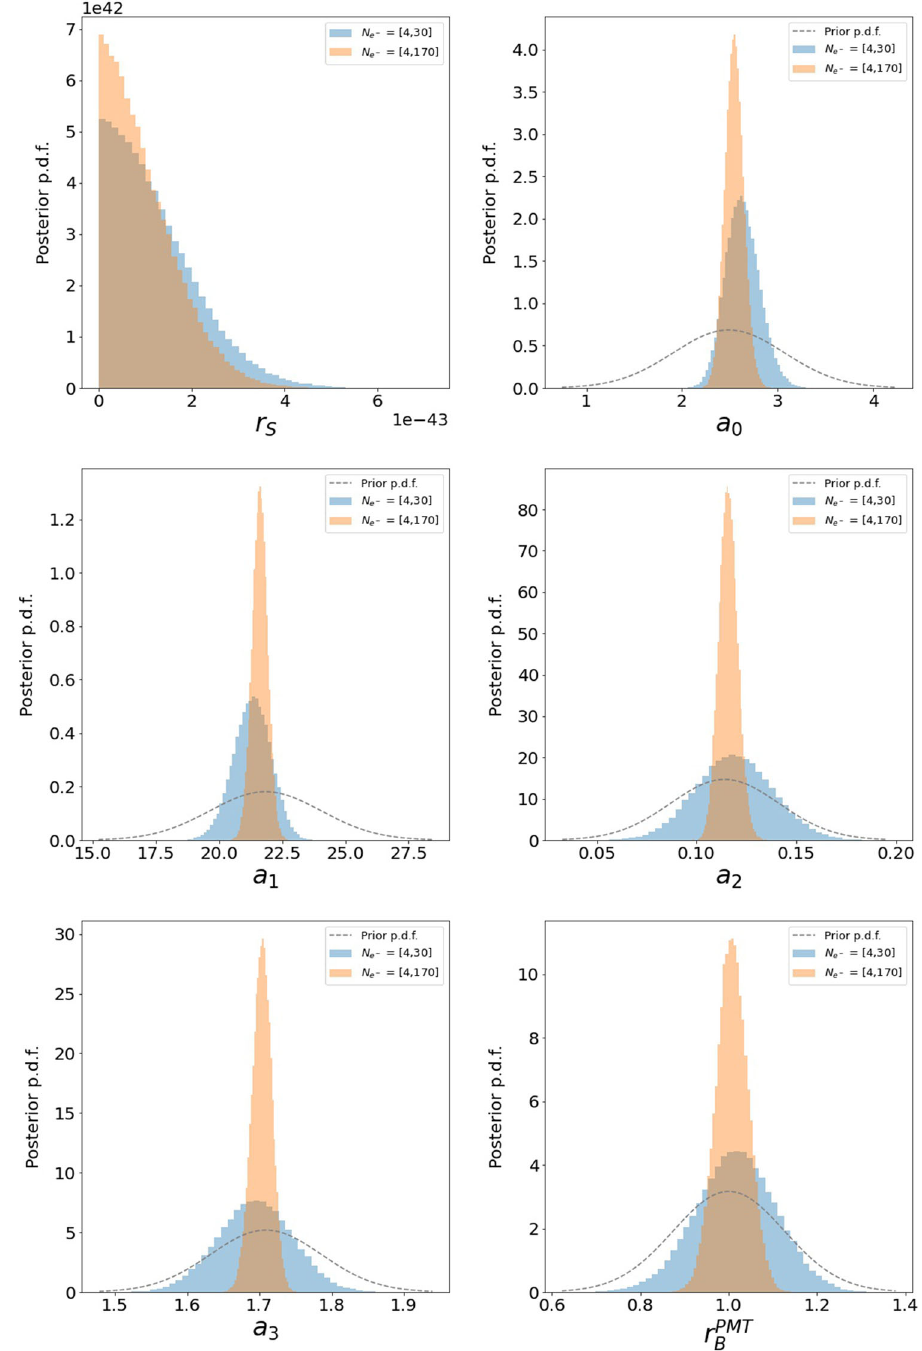
Fig. 7 Posterior pdf s obtained by fitting in different energy ranges a pseudo-dataset with the full background plus signal model assuming a DM mass m DM = 4 . 5 GeV / c 2 . The blue shaded histograms correspond to the N e − = [4 , 30] window, the orange shaded histograms correspond to the N e − = [4 , 170] window, and the gray dashed line are the prior pdf of each